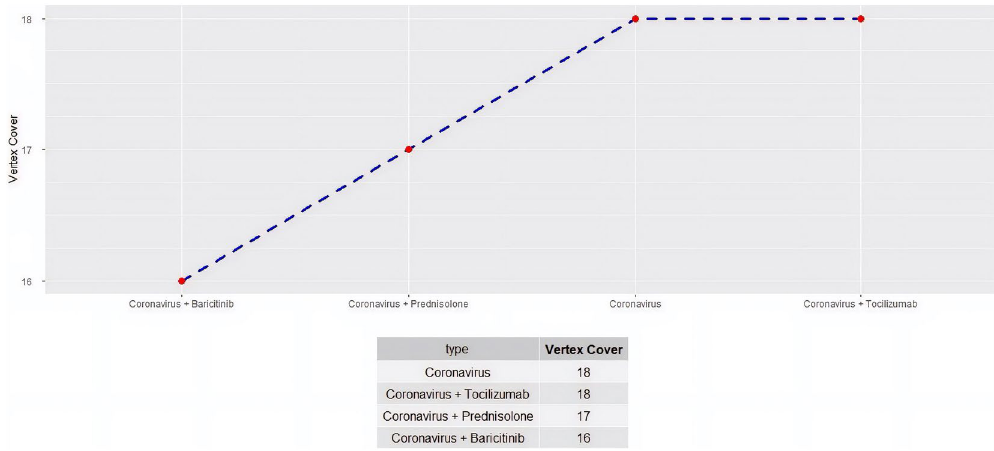
Figure 3. Network size of the human Janus Kinase/Signal Transducers and Activators of Transcription (JAK/STAT) pathway network infected with coronavirus. The system is further tested in terms of size after introduction of immunosuppressive drugs, namely, prednisolone, tocilizumab and baricitinib. In this figure the minimum size of vertex cover is depicted. Similar to Fig. 2, maximum reduction of network size is obtained with baricitinib